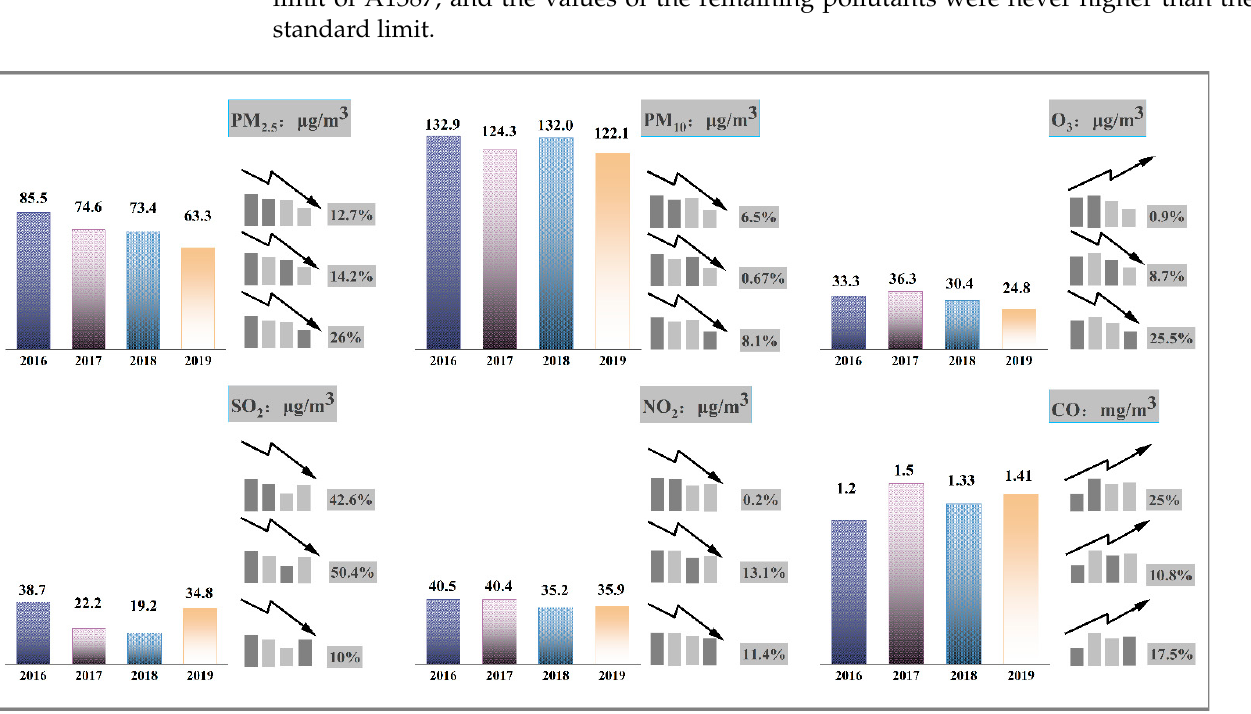
Figure 2. The interannual comparison of the average concentrations of six pollutants in UB from 2016 to 2019 (The annual average percentage change in each pollutant is calculated based on the concentration in 2016).